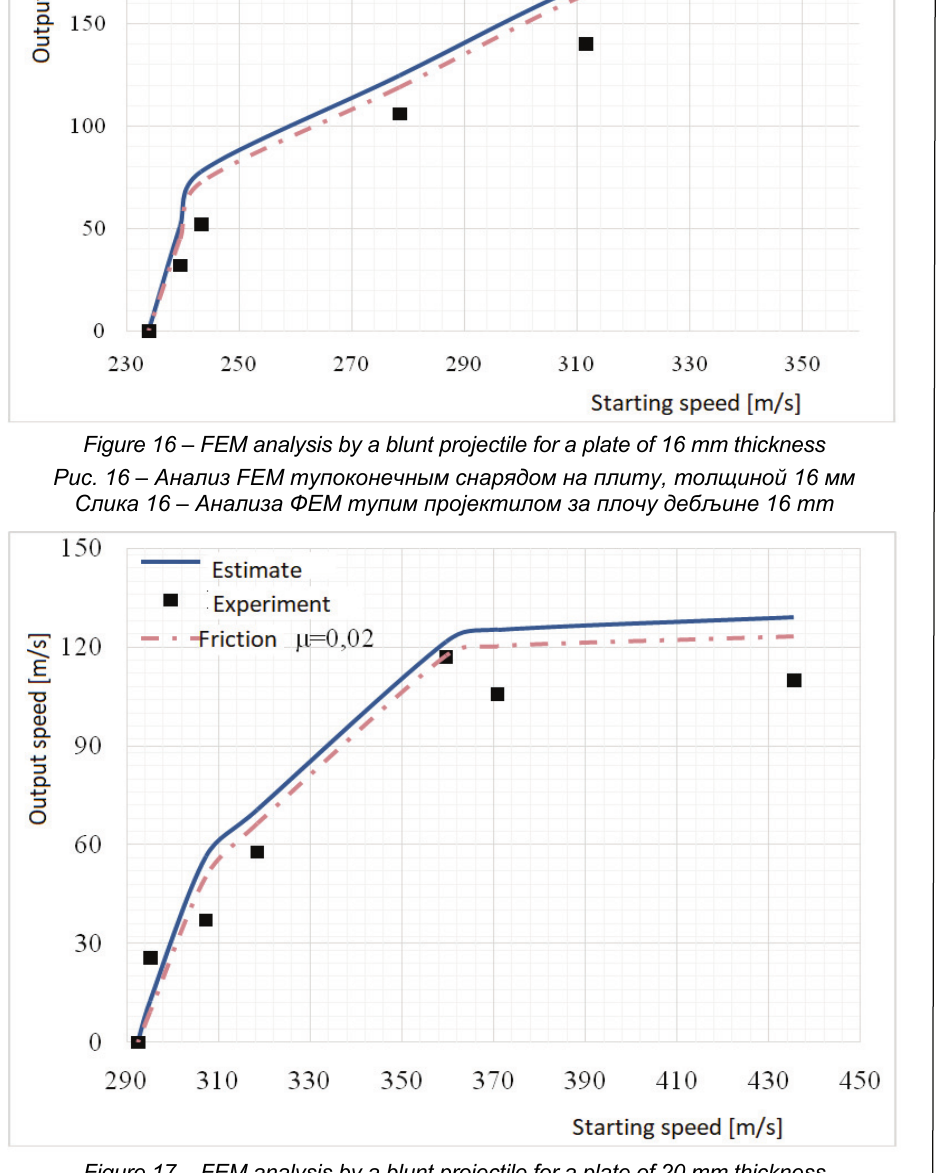
Figure 17 – FEM analysis by a blunt projectile for a plate of 20 mm